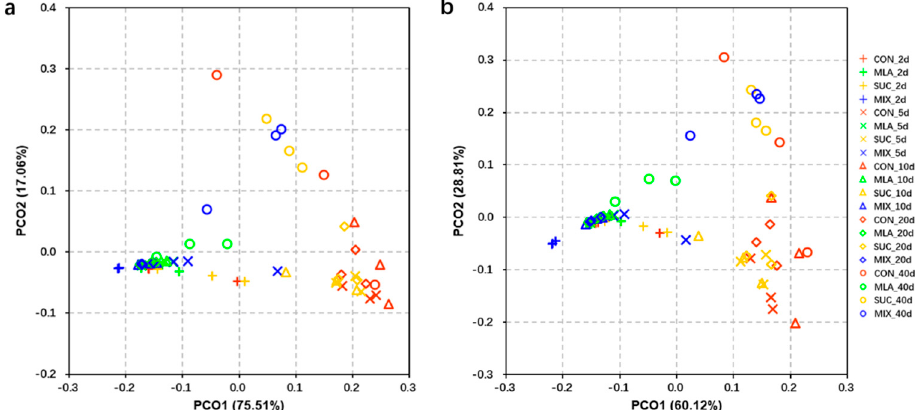
Figure 4. Principal co-ordinates analysis (PCoA) plot of predicted functions ( a ) and pathways ( b ) of the bacterial communities analyzed via PICRUSt. CON, control group; MLA, 1% malic acid addition on the fresh weight (FW) basis; SUC, 1% sucrose addition on the FW basis; MIX, 1% malic acid and 1% sucrose addition on the FW basis.